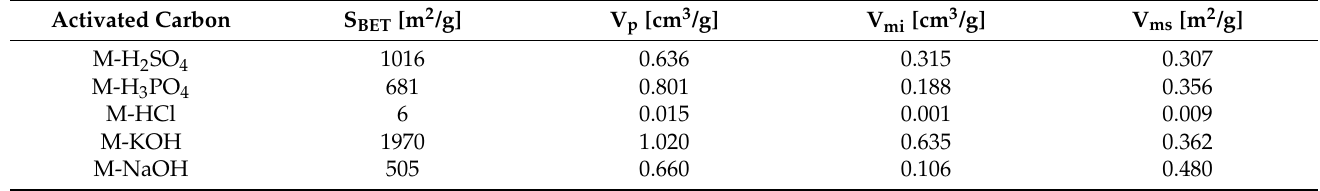
Table 2. Textural properties of activated carbons obtained from